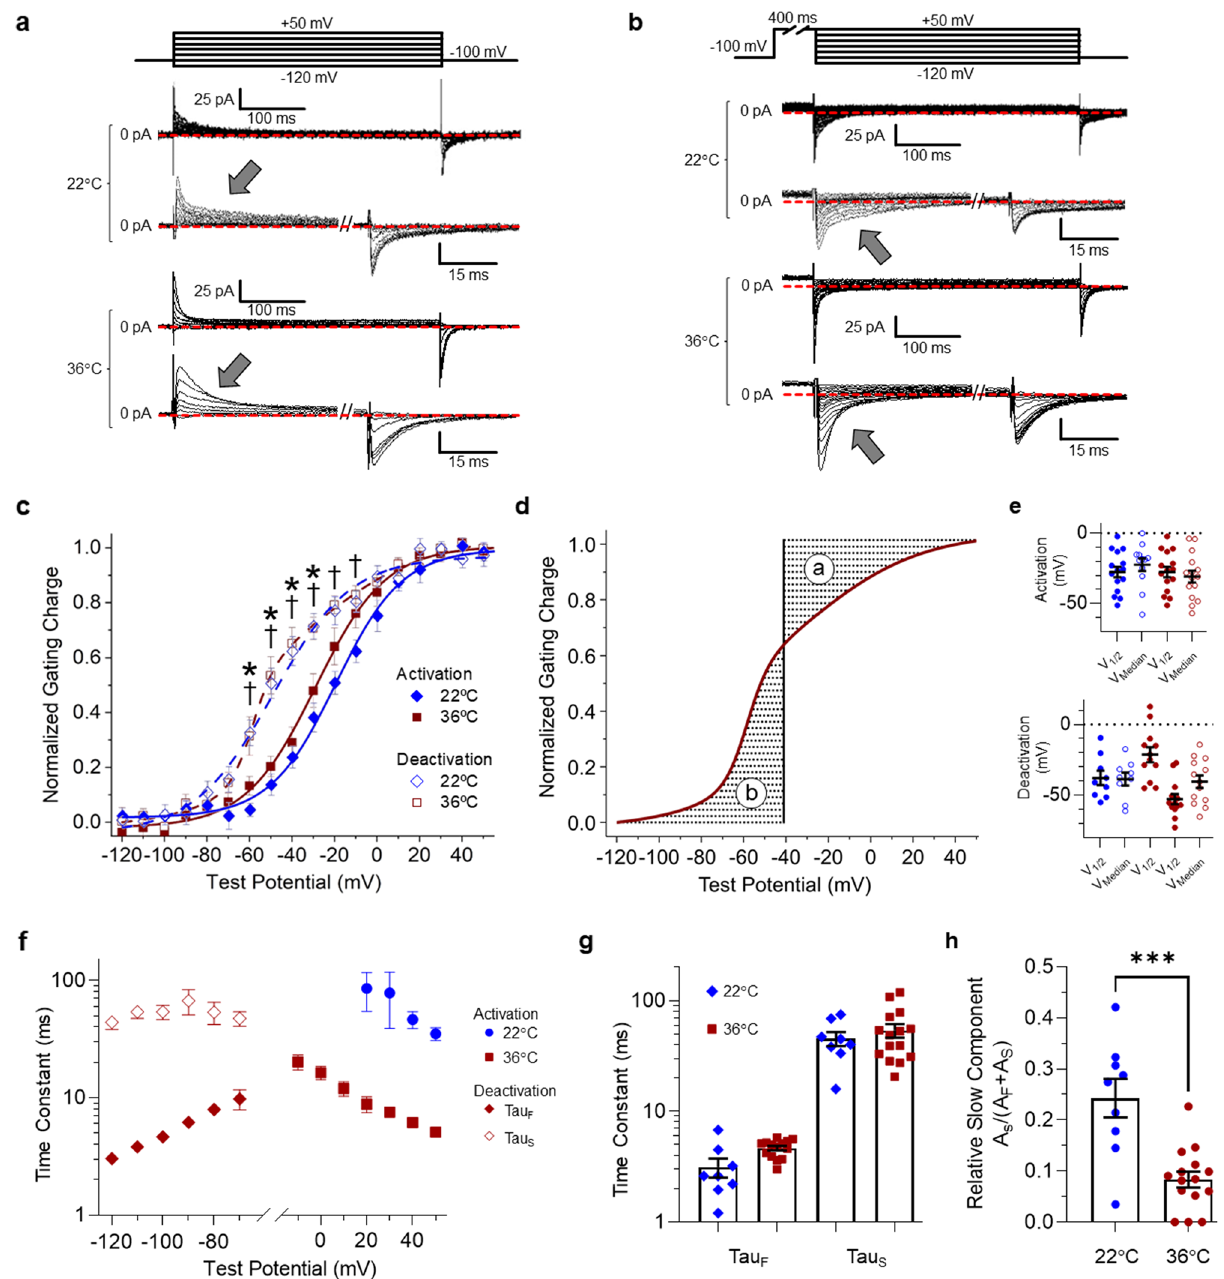
Figure 1. Hysteretic Behavior of hERG 1a gating charge at room temperature (22 °C) and near physiological temperature (36 °C). ( a ) The pulse protocol (top) and corresponding activation gating current traces recorded at 22 °C and 36 °C. An expanded view of the current traces is shown at bottom. The voltage dependence of hERG 1a gating charge activation was measured by recording gating currents elicited by depolarization from a negative (− 100 mV) holding potential. ( b ) The pulse protocol (top) and corresponding deactivation gating current traces (middle). An expanded view of the current traces is shown at bottom. The voltage dependence of hERG 1a gating charge deactivation was measured by recording gating currents elicited by hyperpolarization from a positive (+ 50 mV) holding potential. ( c ) Voltage dependence of hERG 1a voltage sensor activation (filled symbols) and deactivation (open symbols) recorded at 22 °C (blue) and 36 °C (red). Normalized gating charge elicited during the test pulse (arrows) normalized, plotted as a function of test potential, and fitted with either a single Boltzmann (activation) or a double Boltzmann (deactivation) function. The majority of gating charge deactivation occurred at membrane potentials significantly more negative than activation. † indicates p < 0.05 between deactivation and activation at 22 °C. * indicates p < 0.05 between activation and deactivation at 36 °C. ( d ) Graphical representation of the median voltage of charge movement (V median ). The shaded areas “ a ” and “ b ” represent the area between the curve and the ordinate axis. The V median is the point along the X axis where the absolute value of a and b are equal. ( e ) V 1/2 values and V median values for VSD activation (top) and deactivation (bottom) recorded at 22 °C (blue) and 36 °C (red). Two V 1/2 values are reported for deactivation at 36 °C, reflecting the two components of the double Boltzmann. ( f – h ) Time constants of gating current decay are hysteretic. We fitted the decay of gating currents elicited during each test pulse with a single (activation) or double exponential function (deactivation). ( g ) Slow and fast time constants of gating current decay during a deactivating pulse to − 100 mV. ( h ) Relative magnitude of the slow component of gating current decay at − 100 mV. All data are reported as mean ± SEM. *** indicates p < 0.001. n =